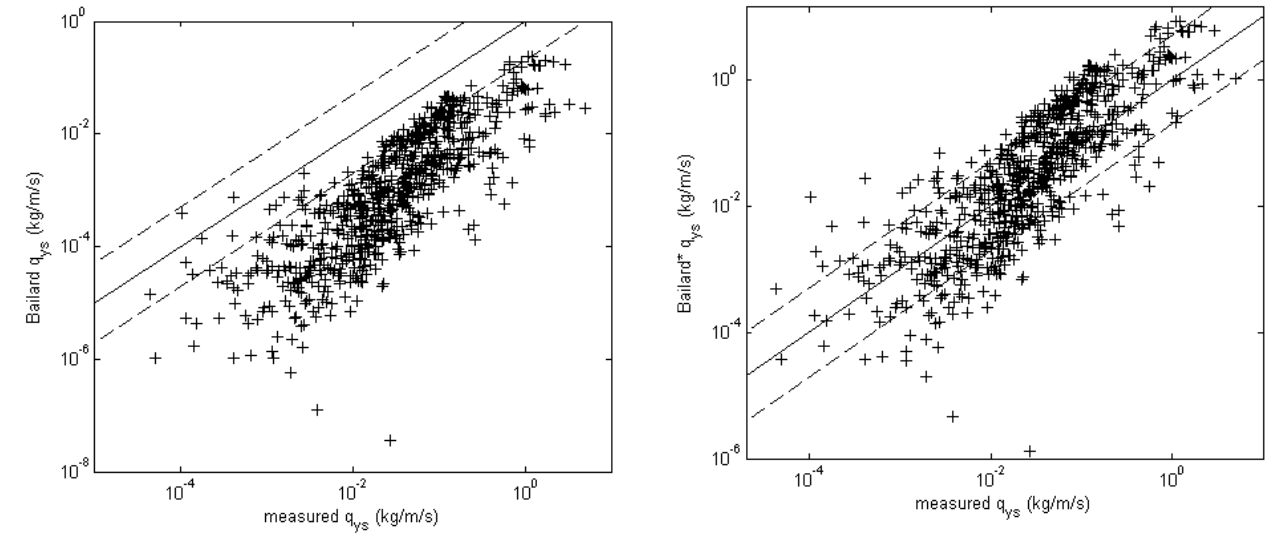
Fig. 4. Comparison of measured and predicted (using a calibrated version of the Bailard formula) values of depth-integrated sus- pended sediment transport. The solid line indicates equality and the dashed lines indicate a factor 5 difference between the predicted and observed